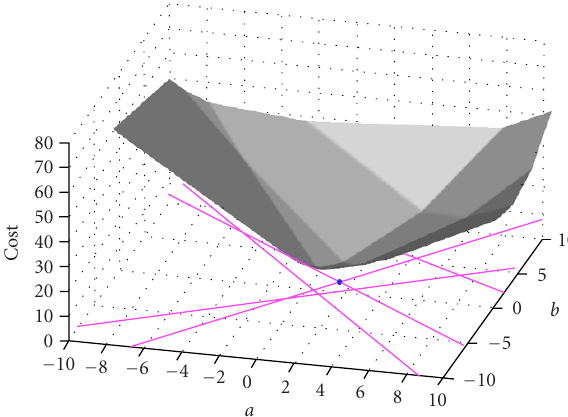
Figure 2: The cost surface of the LAD regression problem. The dot at an intersection on the a - b plane represents the global minimum. To better illustrate the inner topology of the function, the half sur- face that is towards the viewers is cut o ff